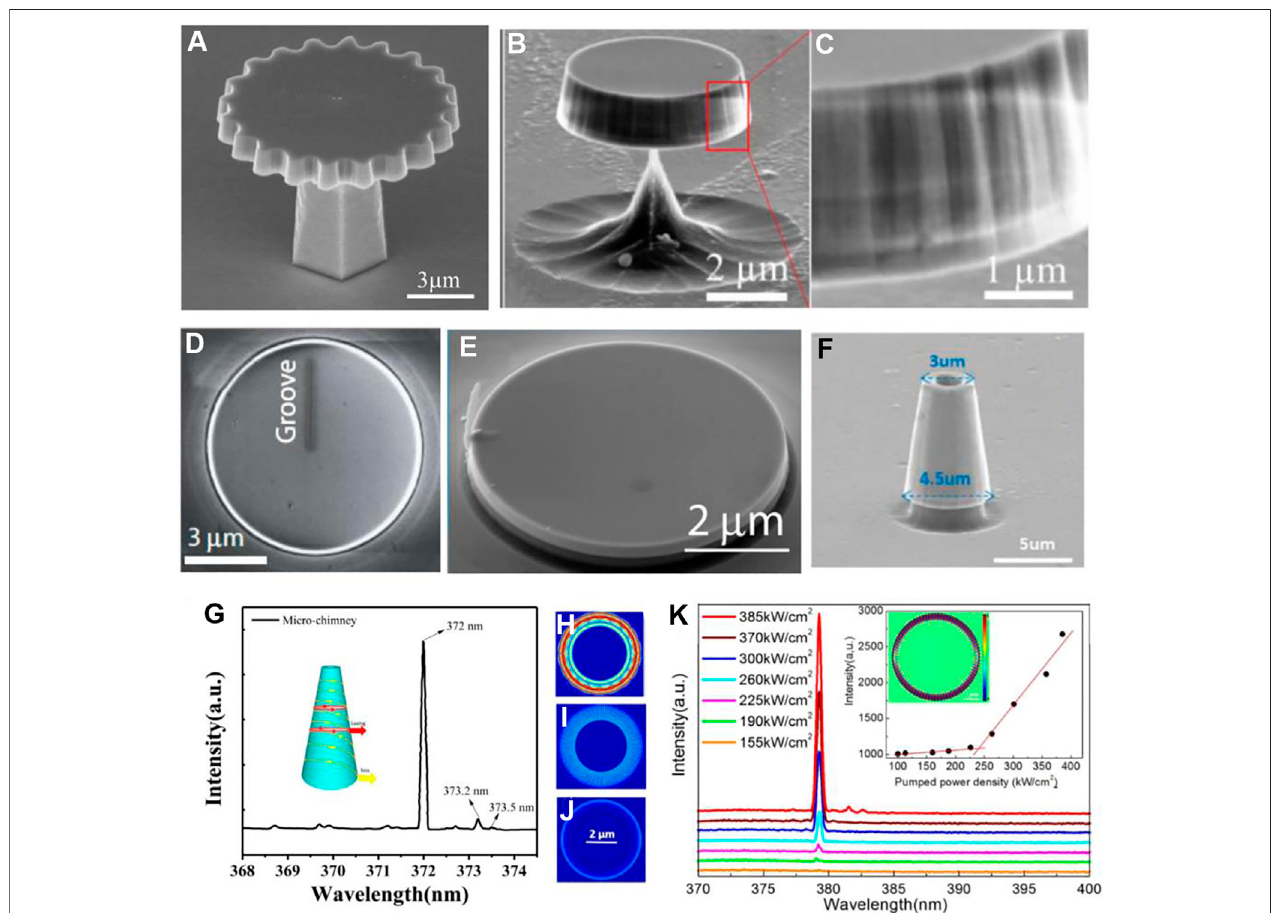
FIGURE 7 | (A) Microdisk with a saw tooth structure for a GaInAsP – InP microdisk (Fujita and Baba, 2002). SEM images of the GaN microdisk with a (B,C) grating alongtheside(Zhuetal.,2018), (D) slit(Bogdanovetal.,2015),and (E) Ptantennastructure(Moiseevetal.,2017). (F) SEMimages, (G) lasingspectra,and (H – J) optical fi eld distribution of the microchimney cavity (Zhu G. Y. et al., 2020). (K) Power-dependent lasing spectra of the GaN microdisk (Zhu et al., 2018). Reprinted with permission © AIP Publishing (Fujita and Baba, 2002), © Optical Society of America (Bogdanov et al., 2015; Zhu et al., 2018), © ACS Publishing (Moiseev al., 2017),